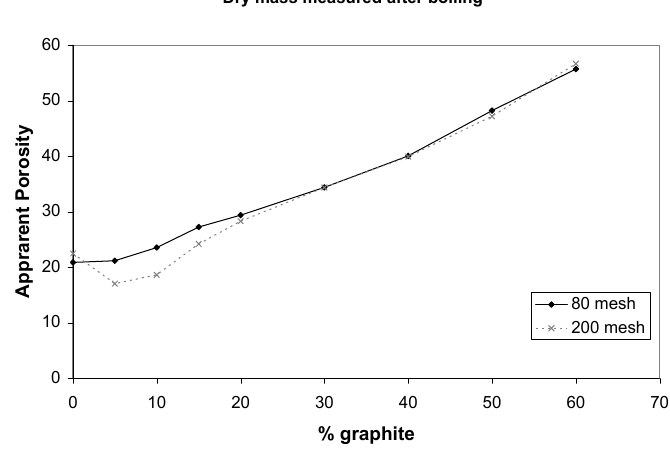
Figure 3. A plot presenting apparent porosity for each alumina sample for increasing % graphite component, or increasing porosity with dry mass measurements taken either before or after